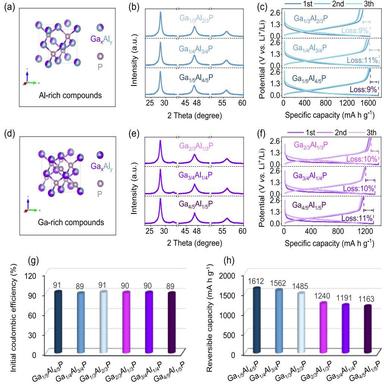
(a and d) Crystal structure. (b and e) XRD patterns. (c and f) First-three GCD profiles. (g) ICE. (h) Reversible capacity of the extended cation-disordered Ga-Al-P-based compounds.